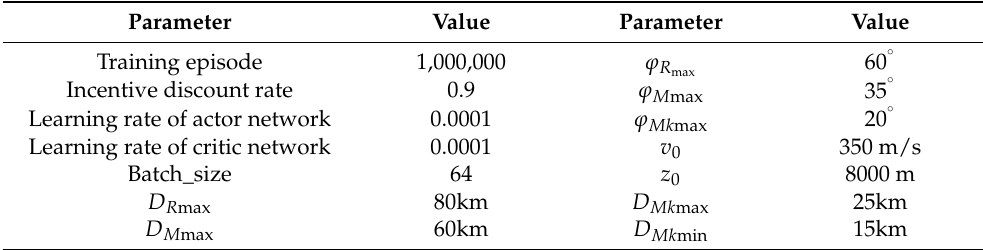
Table 2. Super parameter